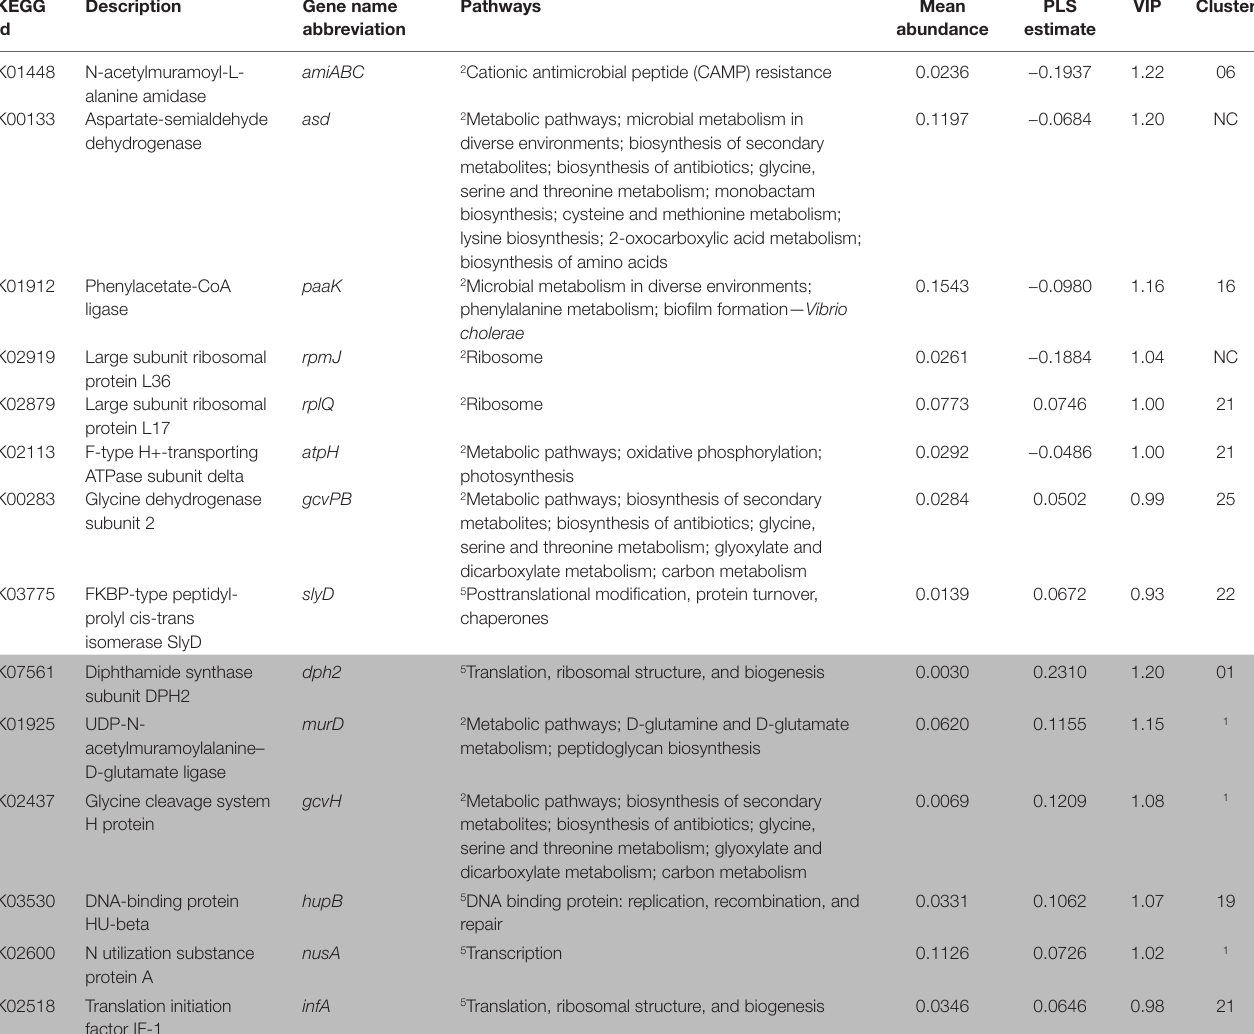
TABLE 3 | Summary of microbial genes identified for the prediction of ADG. KEGG